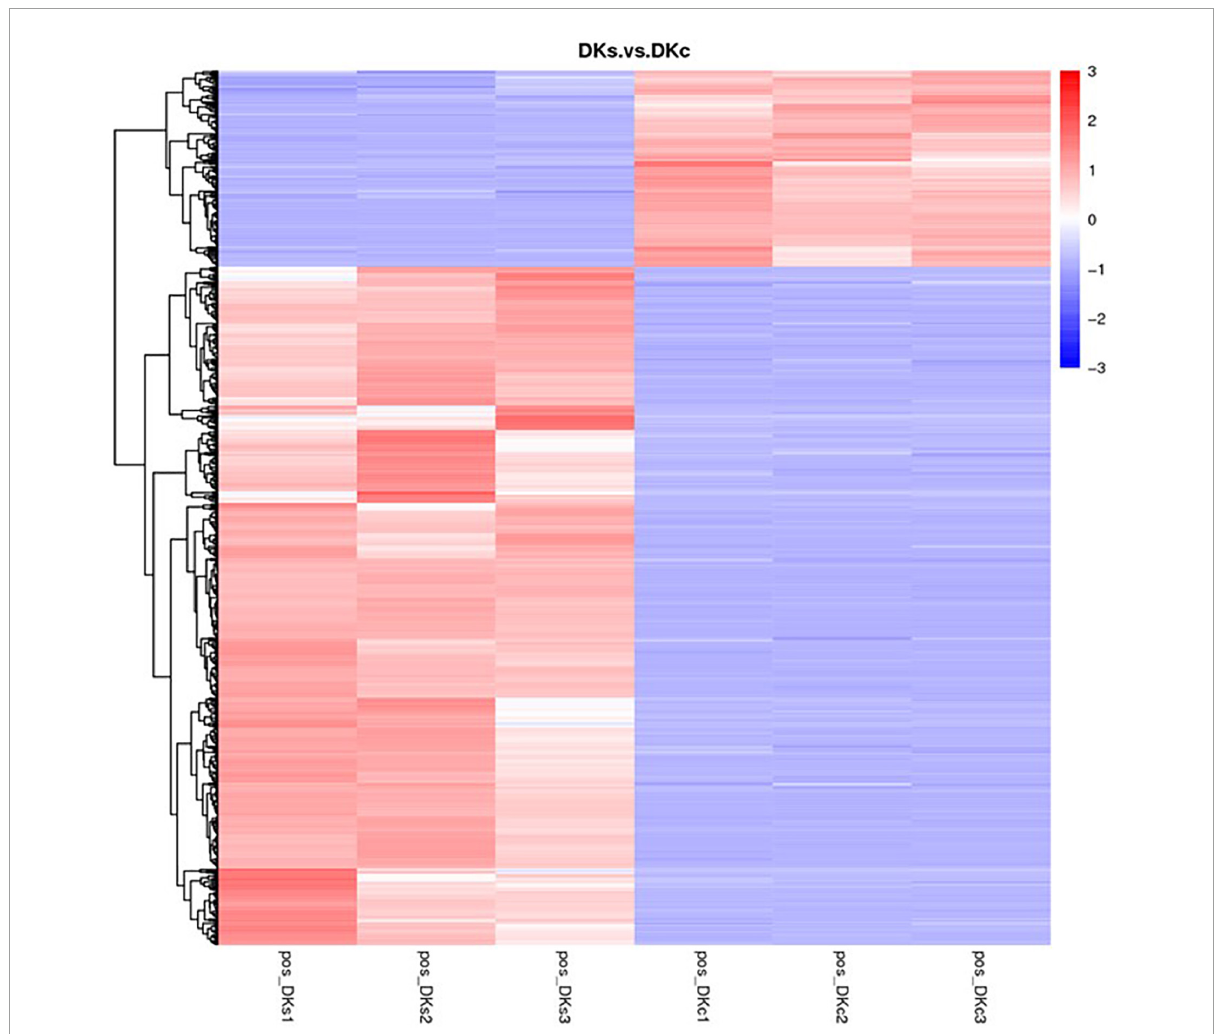
FIGURE5 The metabolites heatmap between the DKc group and DKs group. The threshold was set as VIP > 1.0, FC > 1.5 or FC < 0.667, and P -value < 0.05. Up expression and down expression are presented in red and blue,